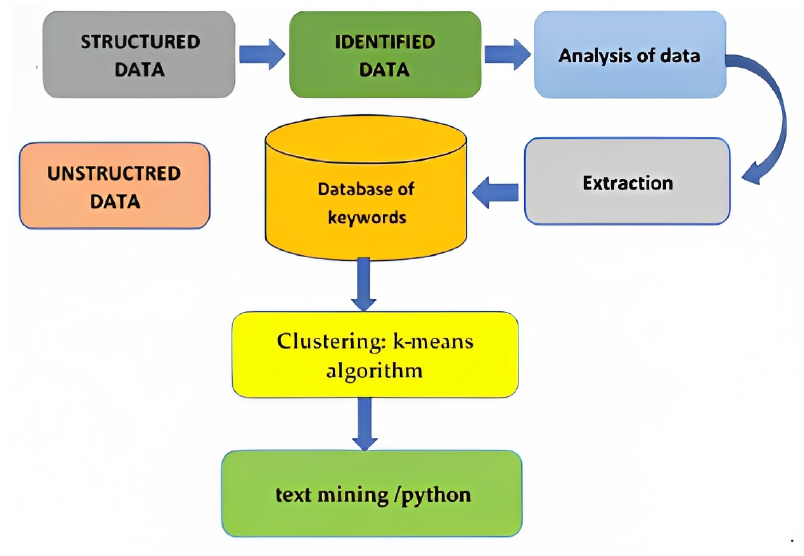
Figure 1. Research